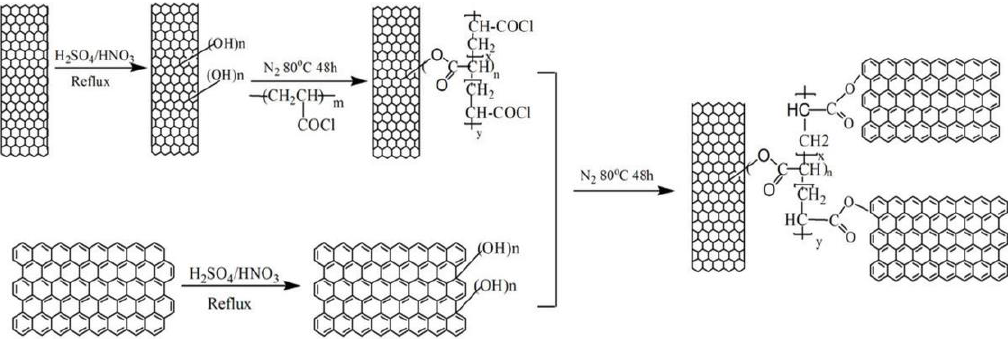
Figure 9. Illustration of the synthesis procedure of multi-walled carbon nanotube MWCNT/graphene (GnP) hybrid materials by the multi-step method [120].